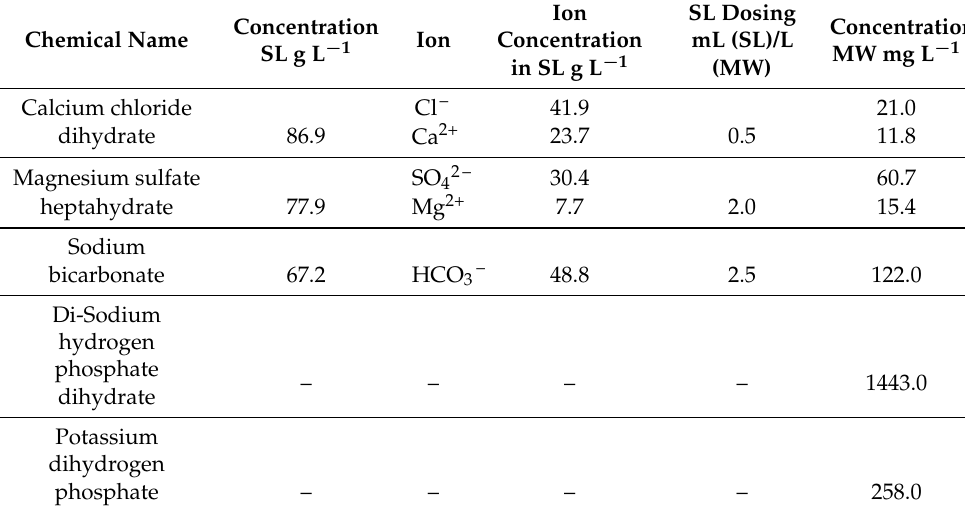
Table 8. E. Test water for pH value medium—Experiment no.5.